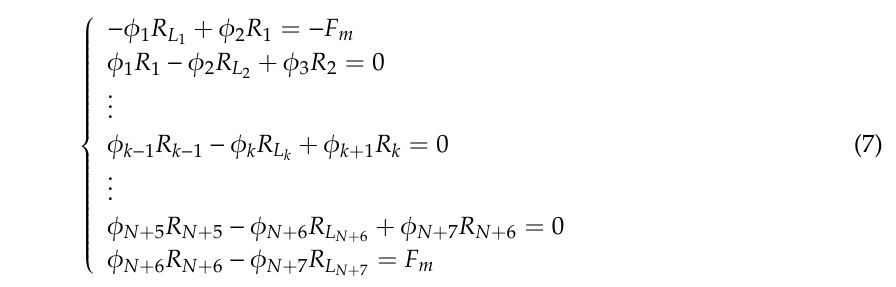
Figure 6. Improved LPMEC model for the RCDMC.